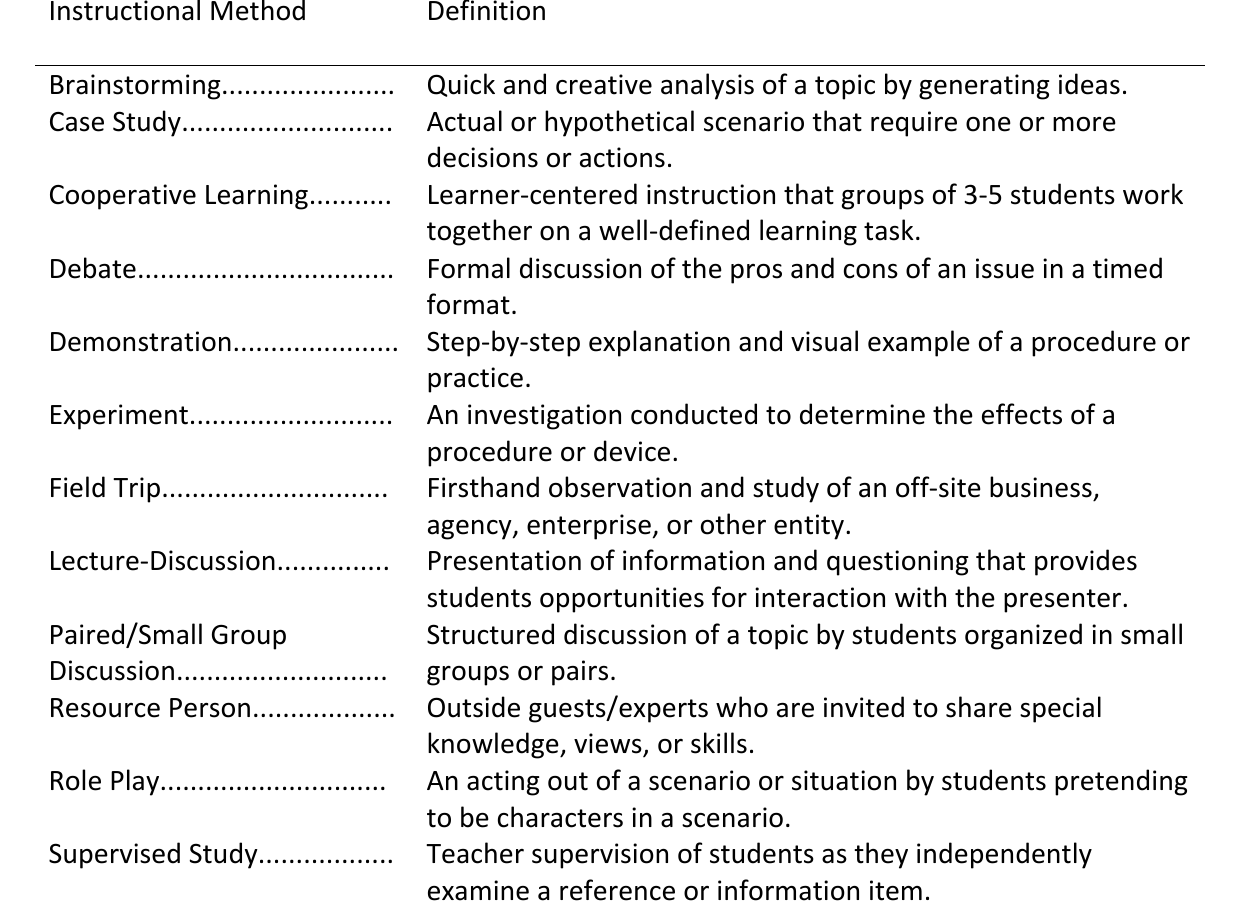
Instructional Methods and Corresponding Definitions